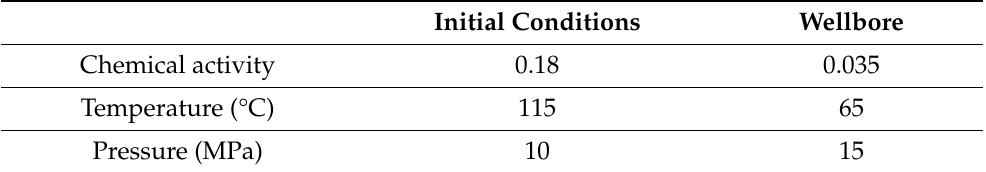
Table 1. Dirichlet boundary conditions used in the FEM numerical simulations.